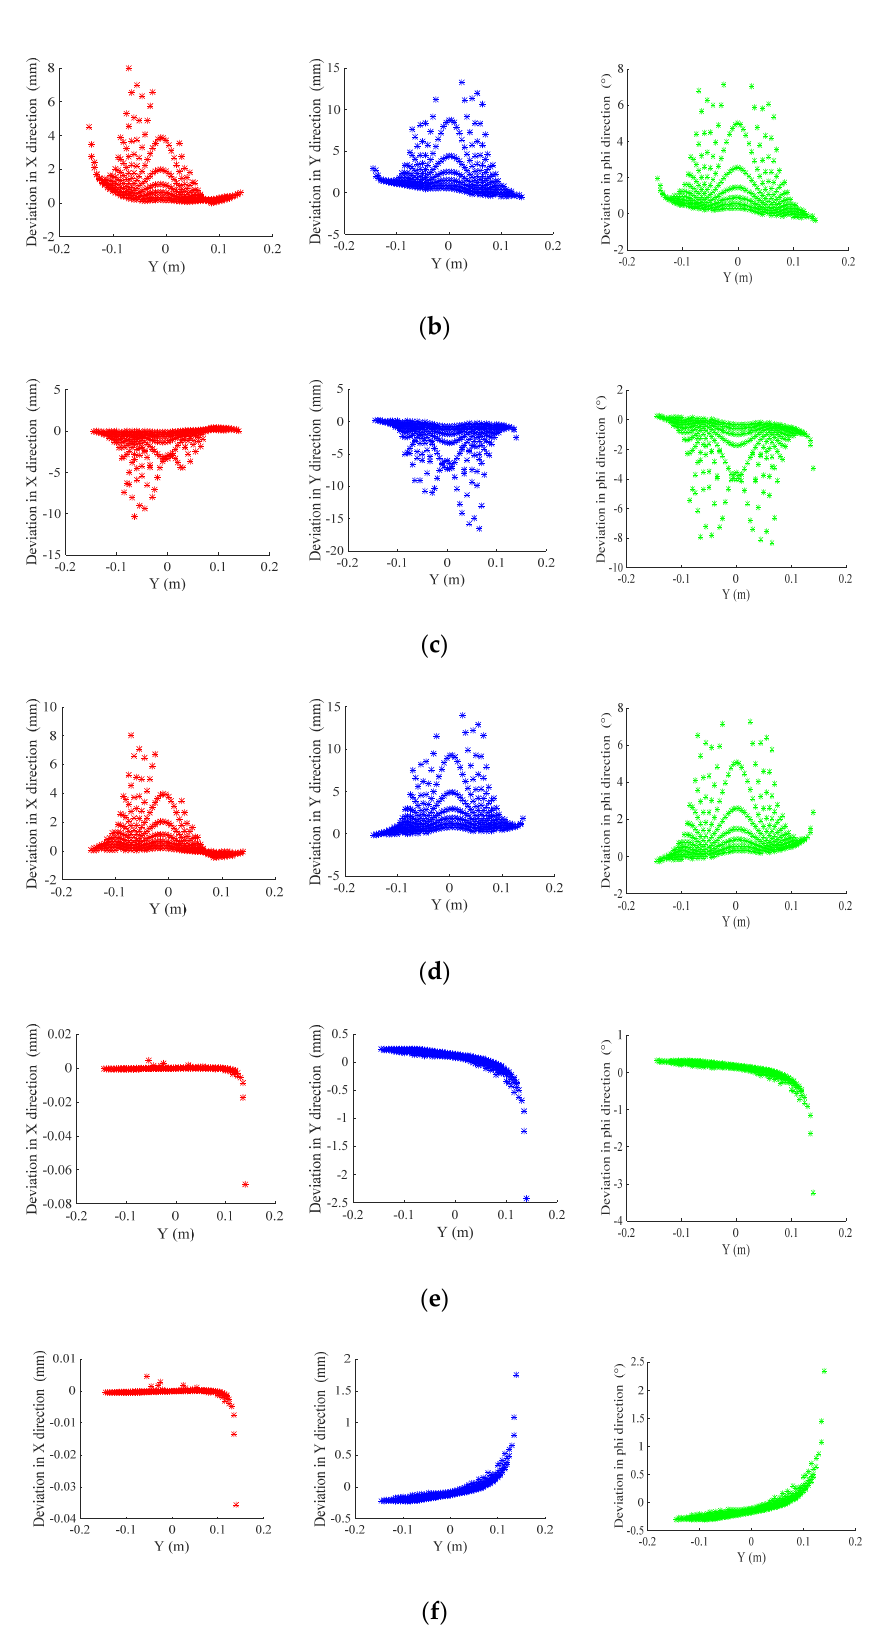
Figure 6. The influence of the cable hole location error on the tip positioning accuracy: ( a ) Adding − 0.35 mm error to the first disk’s holes; ( b ) adding + 0.35 mm error to the first disk’s holes; ( c ) adding − 0.35 mm error to the second disk’s holes; ( d ) adding + 0.35 mm error to the second disk’s holes; ( e ) adding − 0.35 mm error to the third disk’s holes; ( f ) adding + 0.35 mm error to the third disk’s